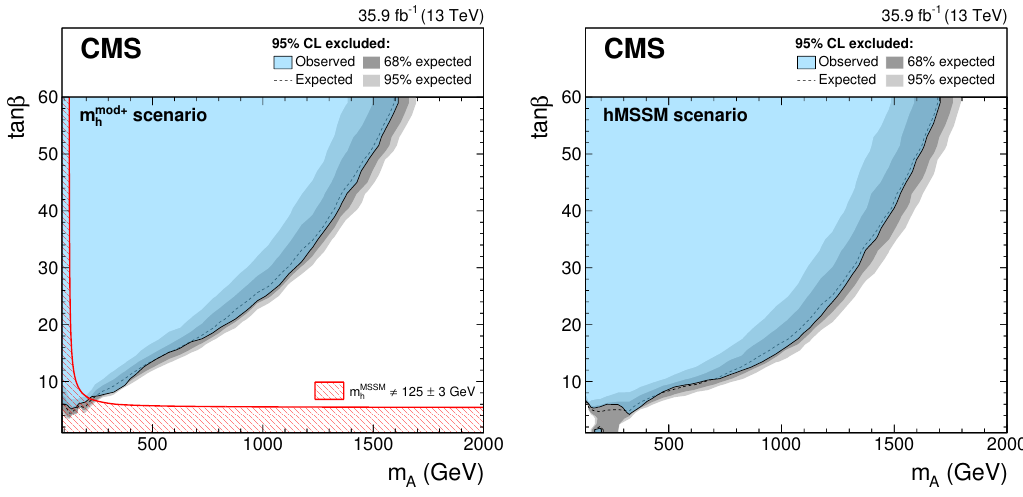
Figure 9 . Expected and observed 95% CL exclusion contour (left) in the MSSM m mod+ in the hMSSM scenarios. The expected median is shown as a dashed black line. The dark and bright gray bands indicate the 68 and 95% con(cid:12)dence intervals for the variation of the expected exclusion. The observed exclusion contour is indicated by the colored blue area. For the m mod+ scenario, those parts of the parameter space, where m h deviates by more then (cid:6) 3 GeV from the mass of the observed Higgs boson at 125 GeV are indicated by a red hatched